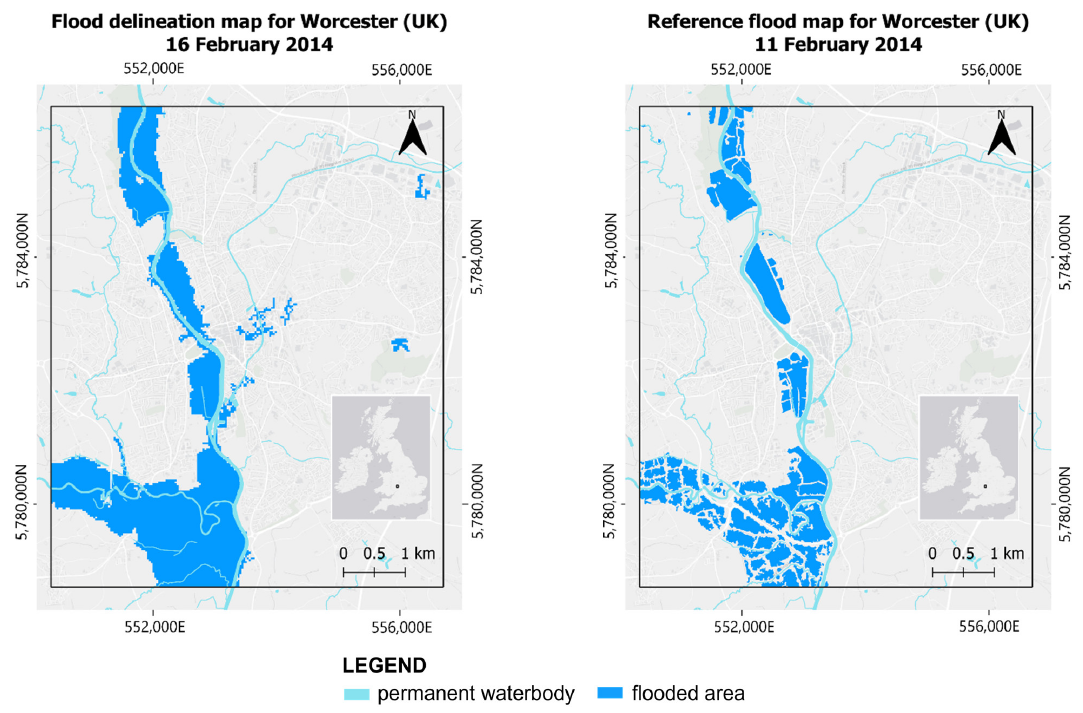
Figure 9. Final flood delineation map ( left panel ) and reference flood map ( right panel ) for the Worcester area (UK). CRS: WGS84/UTM zone 30 N. Basemap data: Esri Gray (light) © Esri.